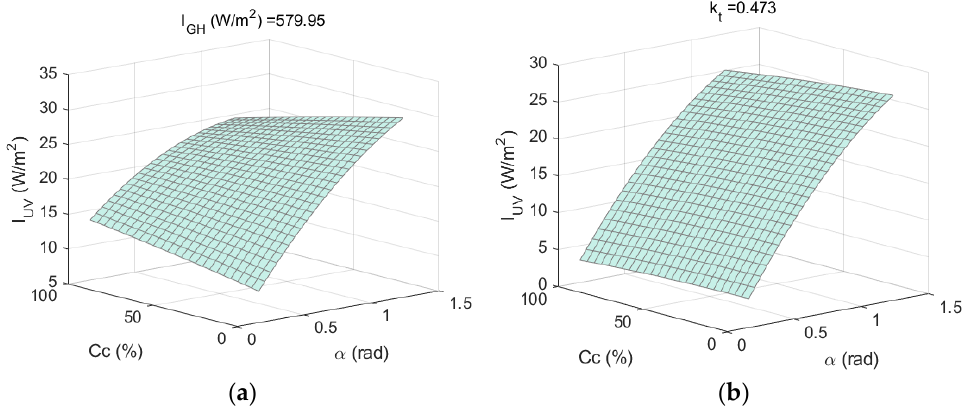
Figure 10. ( a ) I UV vs. ( Cc, α ) |